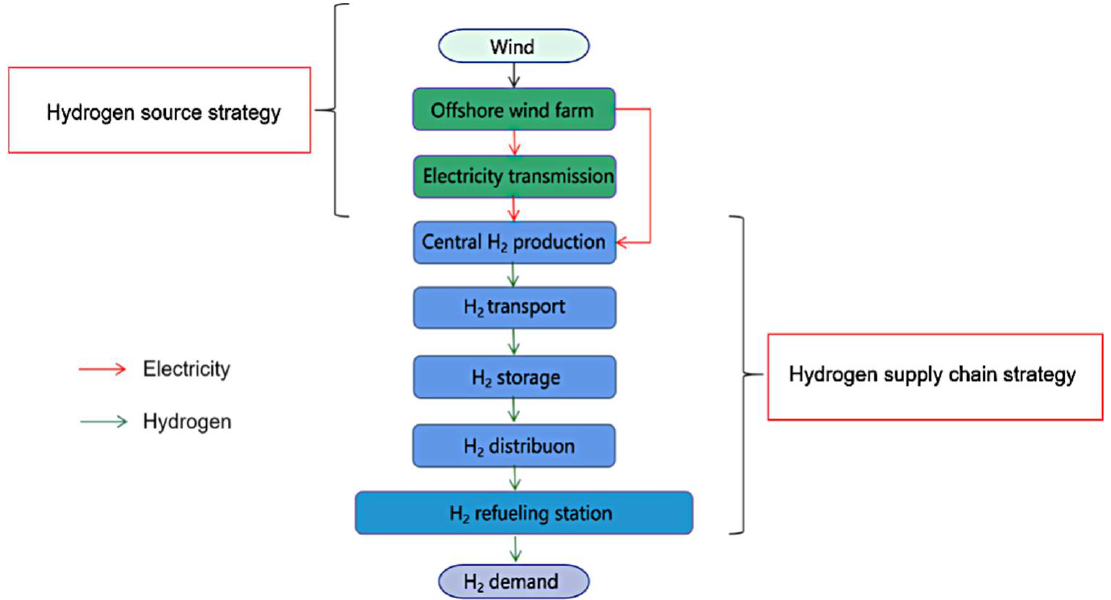
Figure 1. Hydrogen supply chain flow diagram.